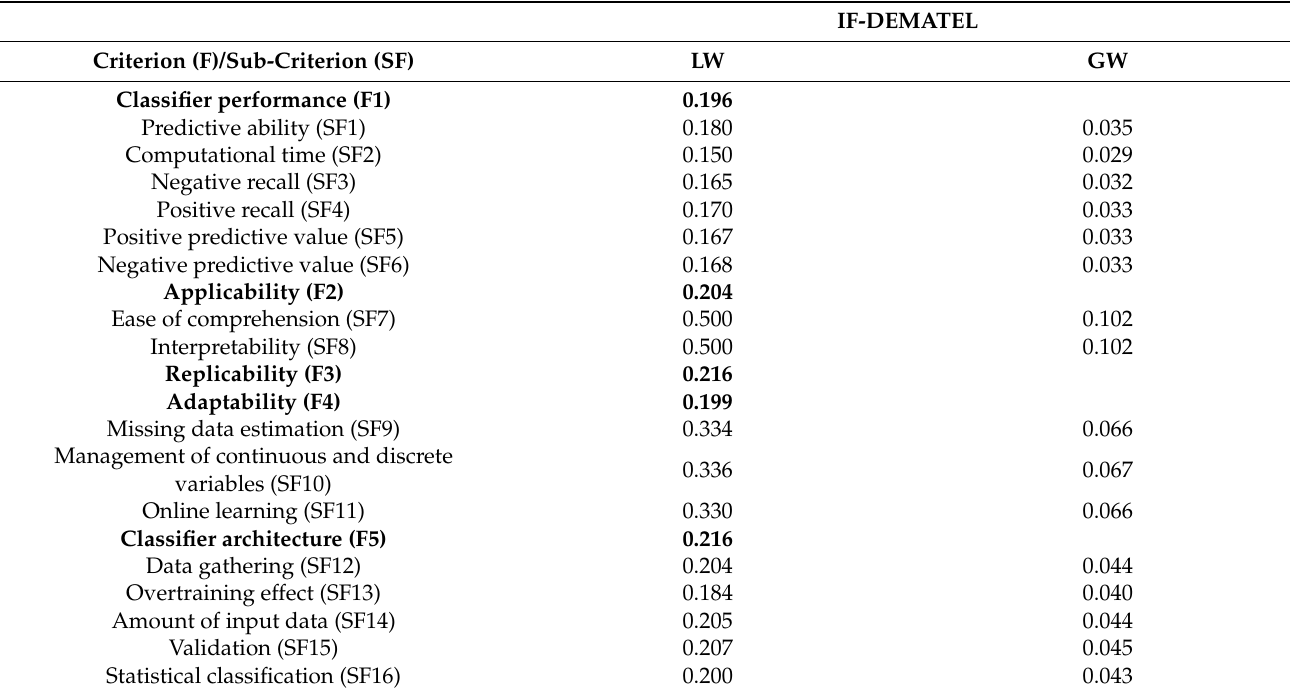
Table 4. Local and global weights of classifier selection